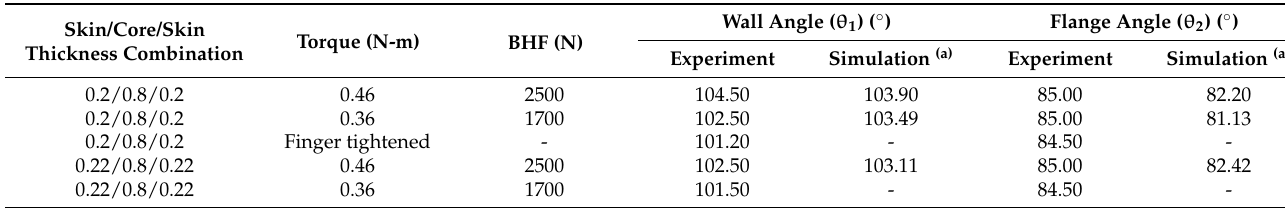
Table 10. Experimental springback results for SA5182/Polypropylene/SA5182.